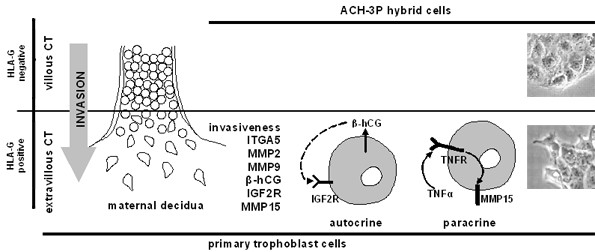
Comparison between HLA-G negative and positive trophoblasts as well as HLA-G negative and positive ACH-3P subpopulations. Both HLA-G positive subpopulations express a higher amount of ITGA5, MMP2, MMP9, β-hCG, IGF2R and MMP15 than their syngeneic, HLA-G negative counterpart. The higher β-hCG secretion and IGF2R expression suggest the presence of an autocrine loop stimulating invasion. Furthermore, the strong effect of TNFα on the up-regulation of MMP15 expression in HLA-G positive cells suggests modulation of trophoblast invasion and/or action by TNFα.